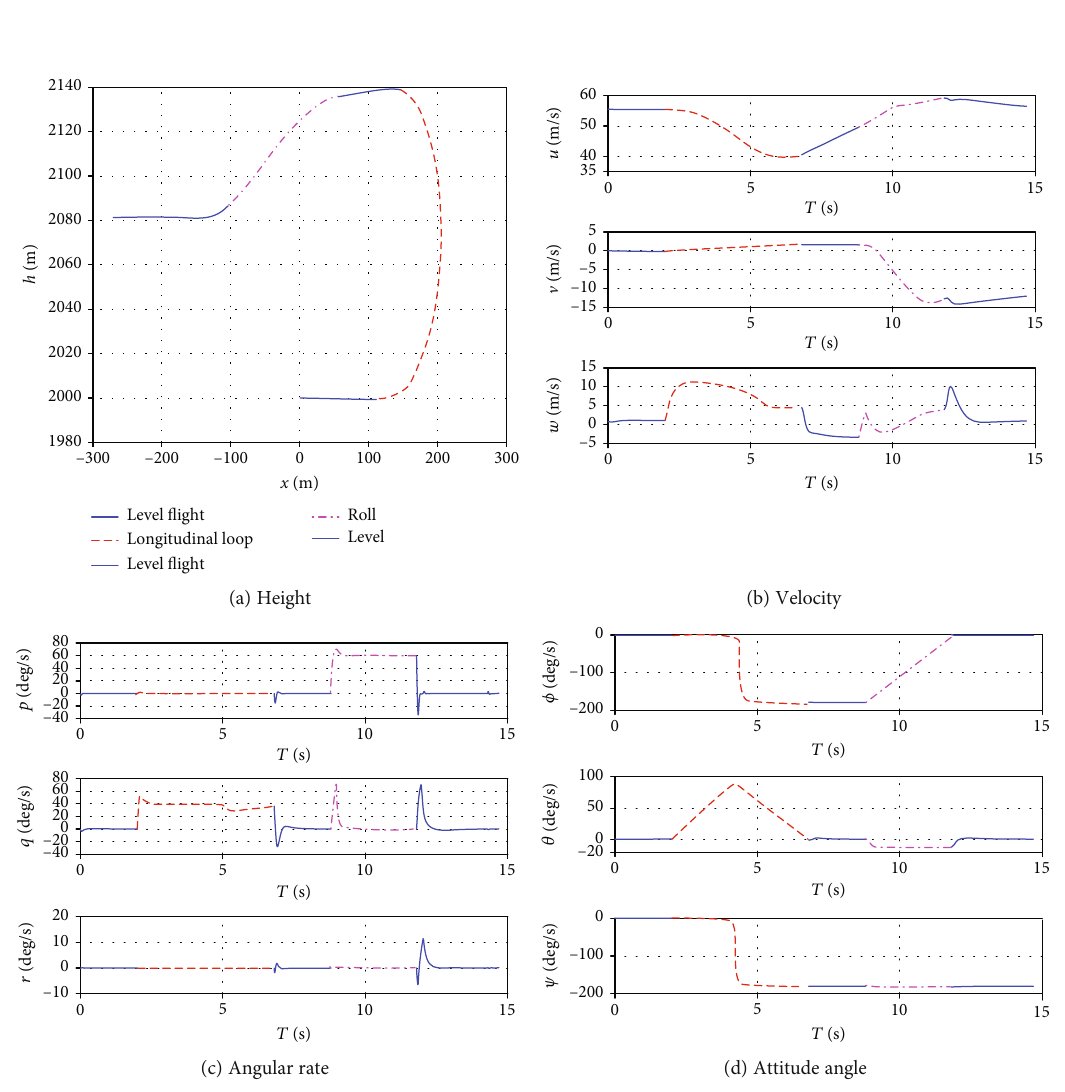
Figure 12: Flight simulation results of the Immelmann-turn maneuver.